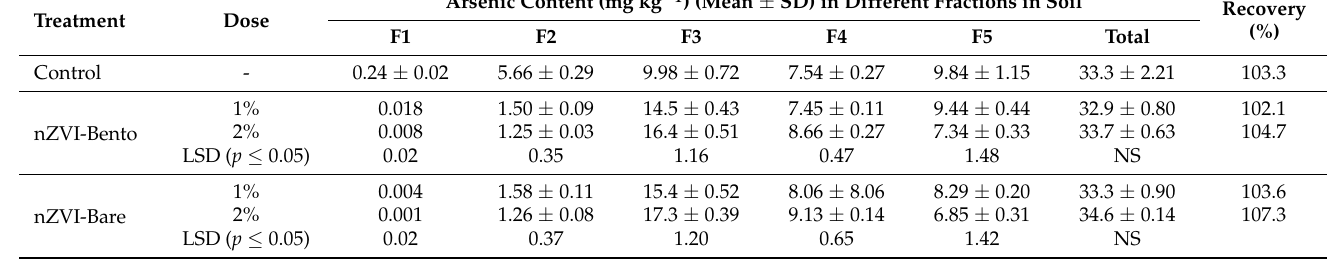
Table 4. Effect of application of graded doses of ZVI product on distribution of As in different fractions in As-contaminated soil .